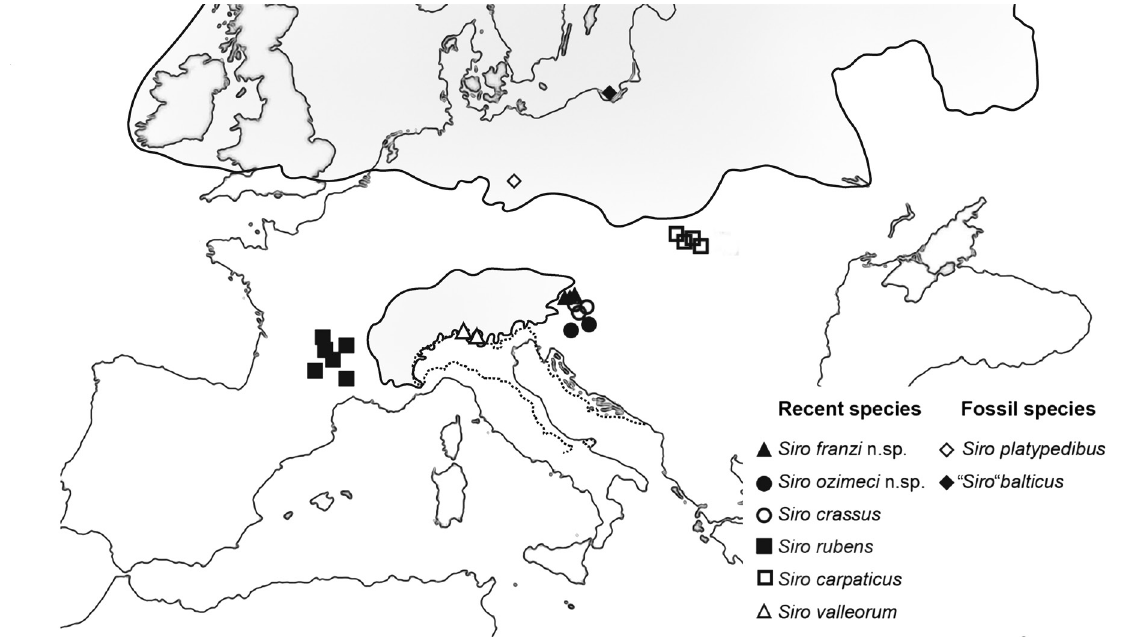
Fig. 1. Distribution of species of Siro Latreille, 1796 in Europe. Shaded areas: the maximum extent of glacial ice in north Europe and Alps during the Pleistocene; dashed line: extension of the northern part of the Adriatic Sea in the early